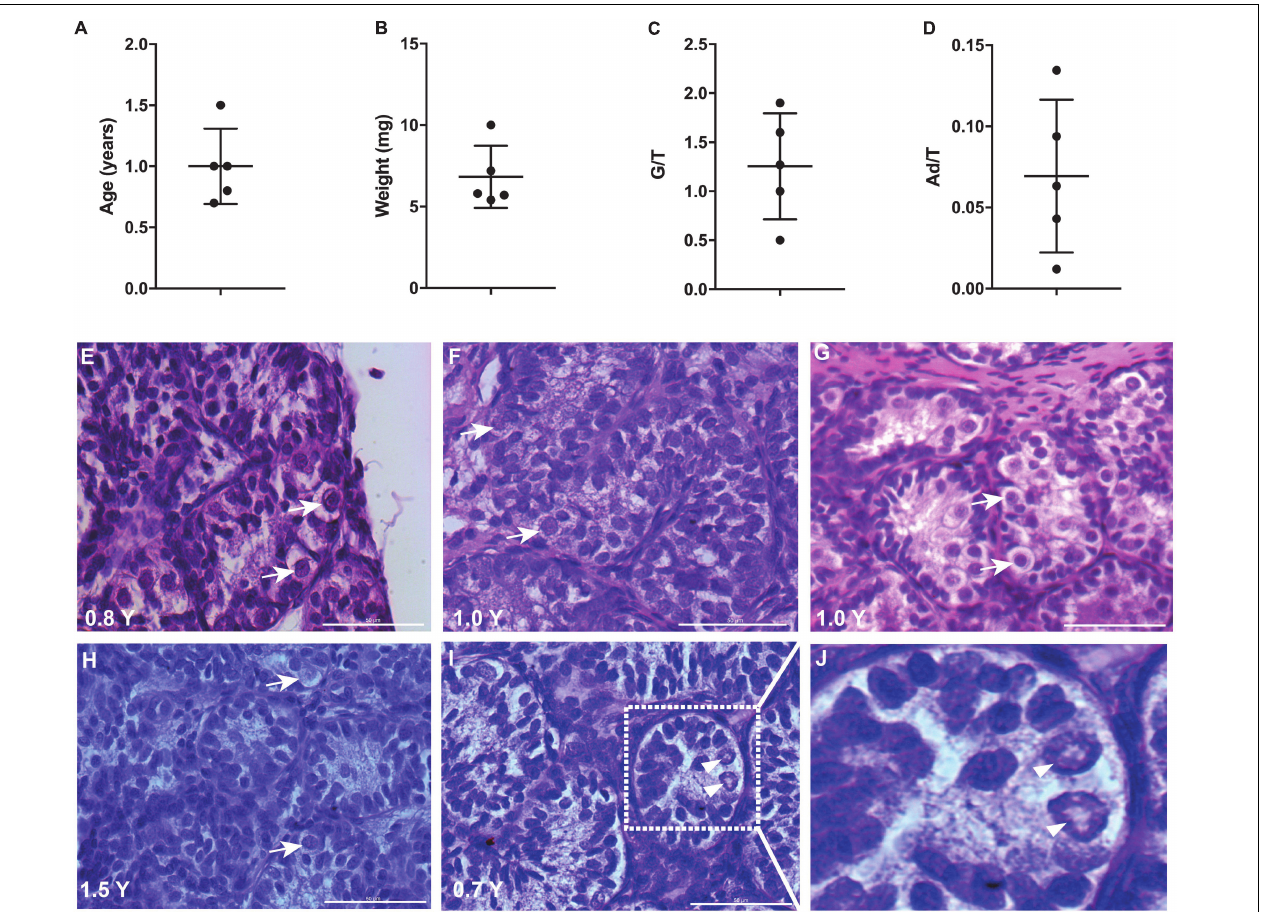
FIGURE 1 | Testicular biopsies analysis for culture. (A,B) The age and weight of biopsies, error bars represent standard deviations. (C,D) Germ cell (G/T) number and A d spermatogonia (Ad/T) number per tubular transverse section in five cryptorchid boys. Mean and standard deviations are shown. (E–I) Histological profile of testicular biopsies from five individual samples. Scale bar: 50 µ m. White arrows indicate germ cells. (J) , higher magnification from I demonstrates the rarefaction zone in nuclear indicating A d spermatogonia. Arrow heads indicate A d